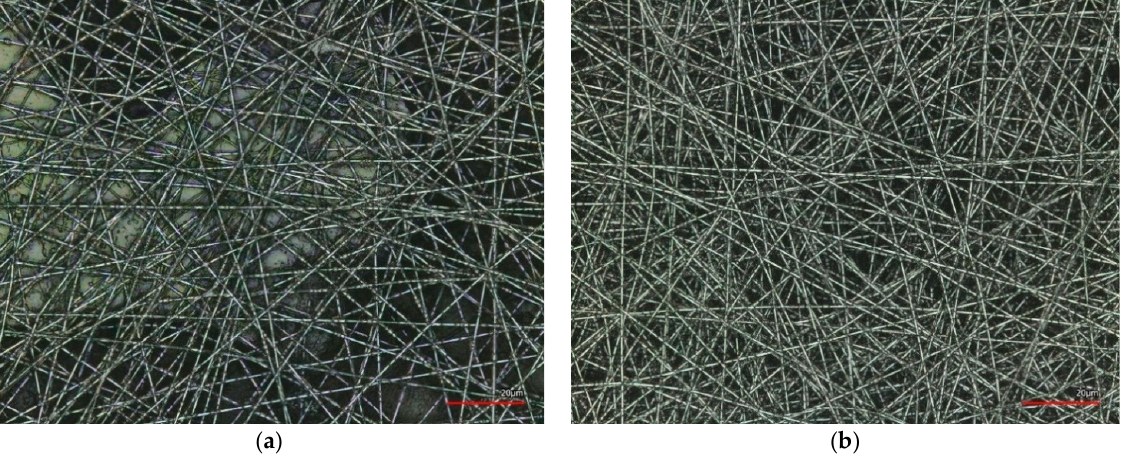
Figure 13. Confocal laser scanning microscope (CLSM) images of PAN/gelatin nanofiber mats on PJM object. PJM object is covered with nanofibers and is not visible: ( a ) sample—37, ( b ) sample—38. Scale bars indicate 20 μ m.